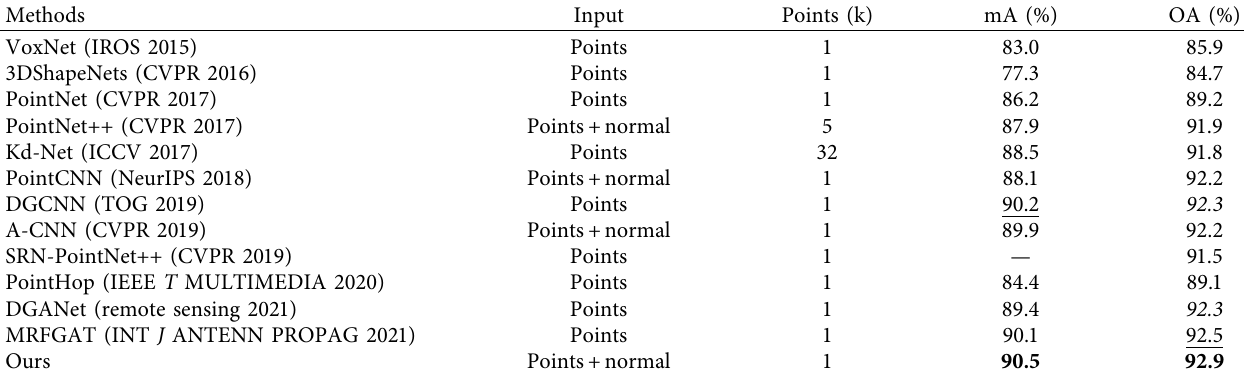
Table 3: Classification performance on ModelNet40. (The top three accuracies are highlighted by bold, underline, and italic.) Methods